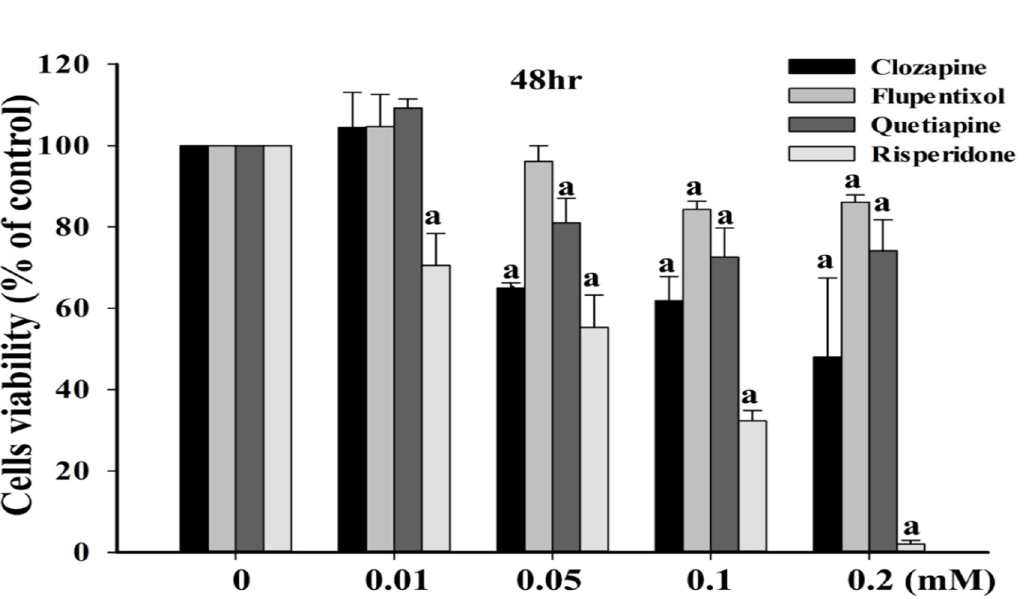
Figure 1. Effects of different antipsychotics on the survival of SW480 cells. “a” indicates a significant difference ( p < 0.05) compared with clozapine, flupentixol, quetiapine, or the risperidone control (0 mM), respectively. Similar results were obtained in three to six repeated experiments.